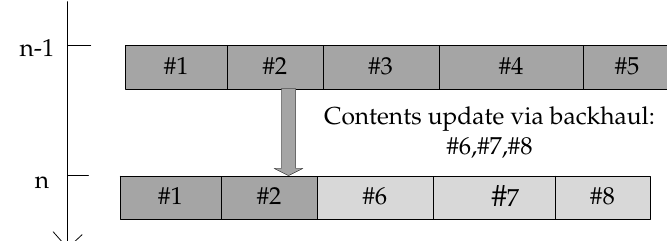
Figure 2. Illustration of content update between two successive time slots, ( #6,#7,#8 ) represent the contents updated via the backhaul